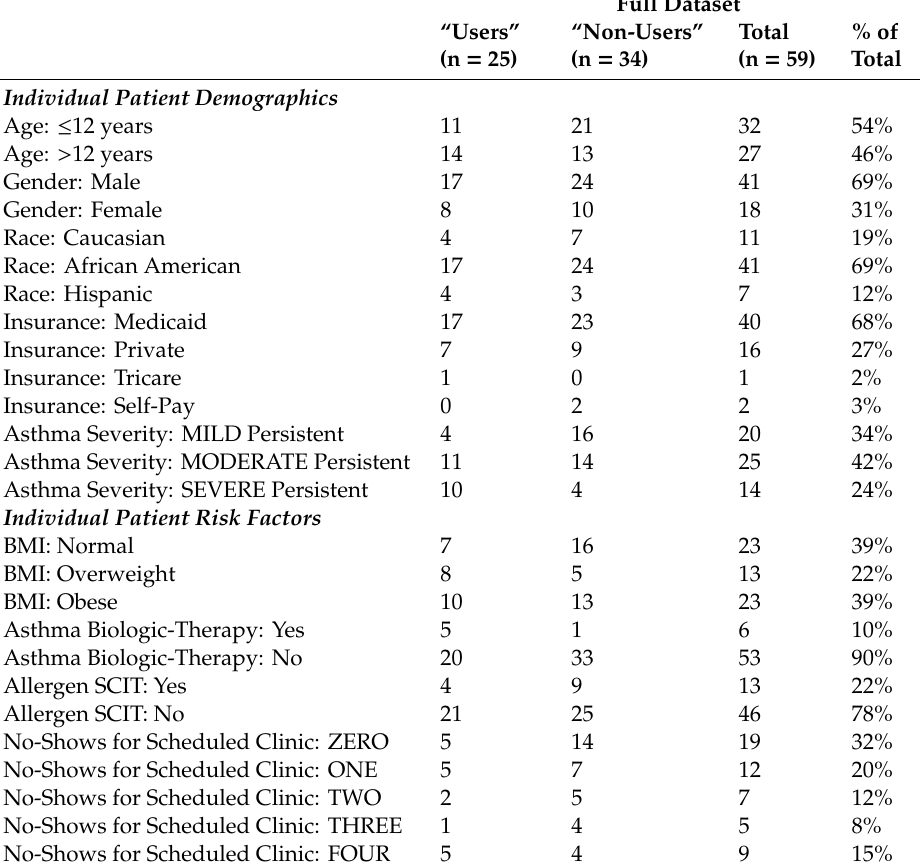
Table 1. Frequency distribution of users and non-users by demographic and risk